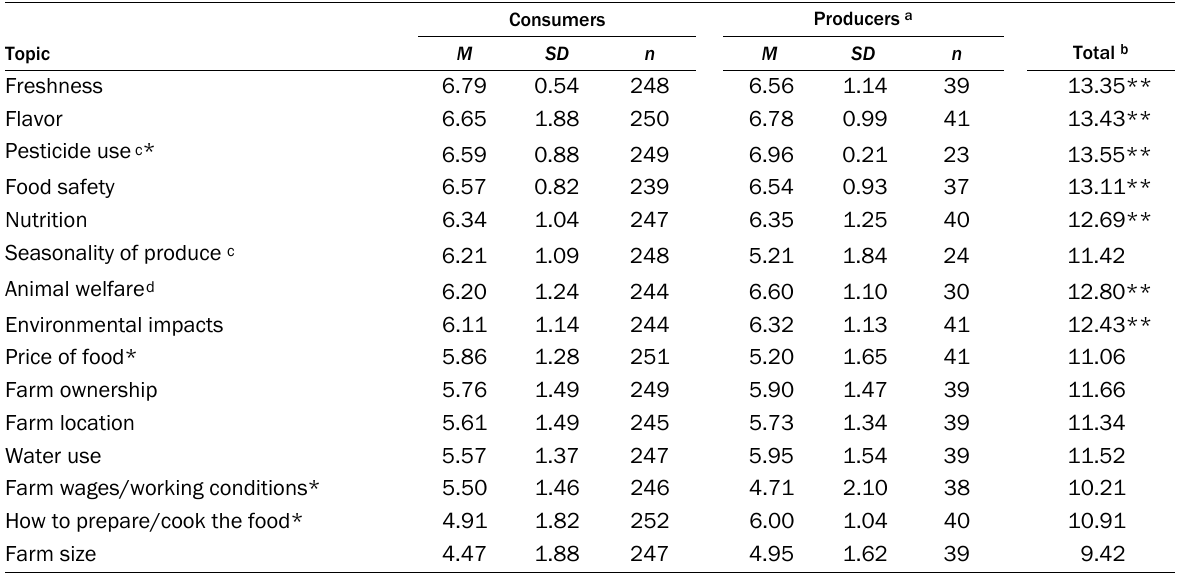
Table 4. Mean Ratings of Desired Food-Related Information